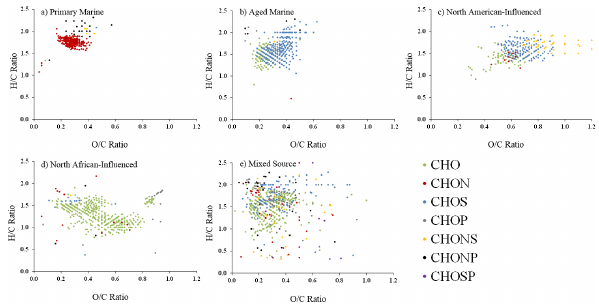
Figure 6. van Krevelen diagrams corresponding to the WSOM load- ings for the sample groups assigned by the PCA and classified as (a) Primary Marine, (b) Aged Marine, (c) North American-influenced, (d) North African-influenced, and (e) mixed source samples. Data points are color coded for molecular formula elemental composition as described in the figure key in the final